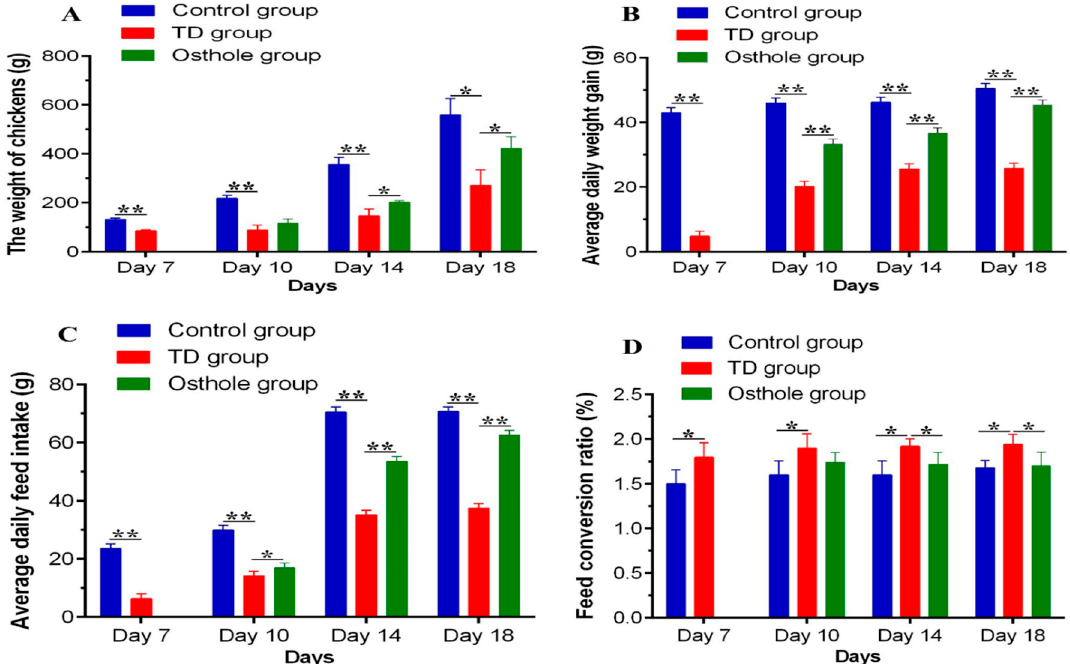
Figure 5. Production parameters analysis among groups on the 7th, 10th, 14th, and 18th days: ( A ) AW, ( B ) ADWG, ( C ) ADFI, and ( D ) FCR. The data are expressed as the mean ± SD. * p < 0.05. The standard FCR value in this study was 1.6.